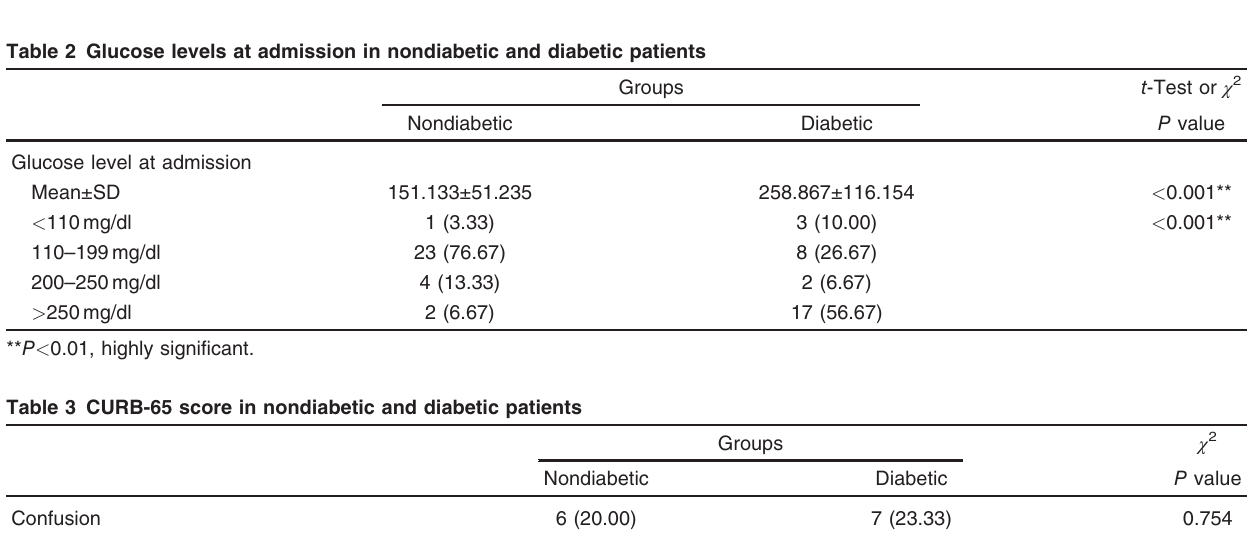
Table 2 Glucose levels at admission in nondiabetic and diabetic patients